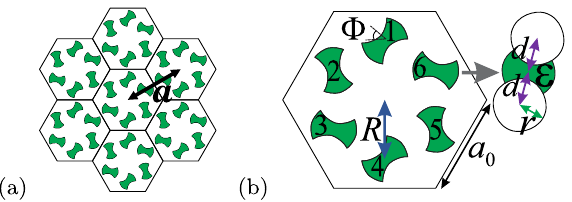
Figure 1. Unperturbed 2D Photonic Crystal. ( a ) Scheme of the triangular lattice with six dumbbell-shaped rods. ( b ) Scheme of the unit cell of the unperturbed dumbbell-shaped rod photonic crystal. Here a 0 R a / 3 is the distance from the center of the unit cell to the center of the dumbbell-shaped rod, r = d R / 2 and (cid:31) is the angular orientation of each =